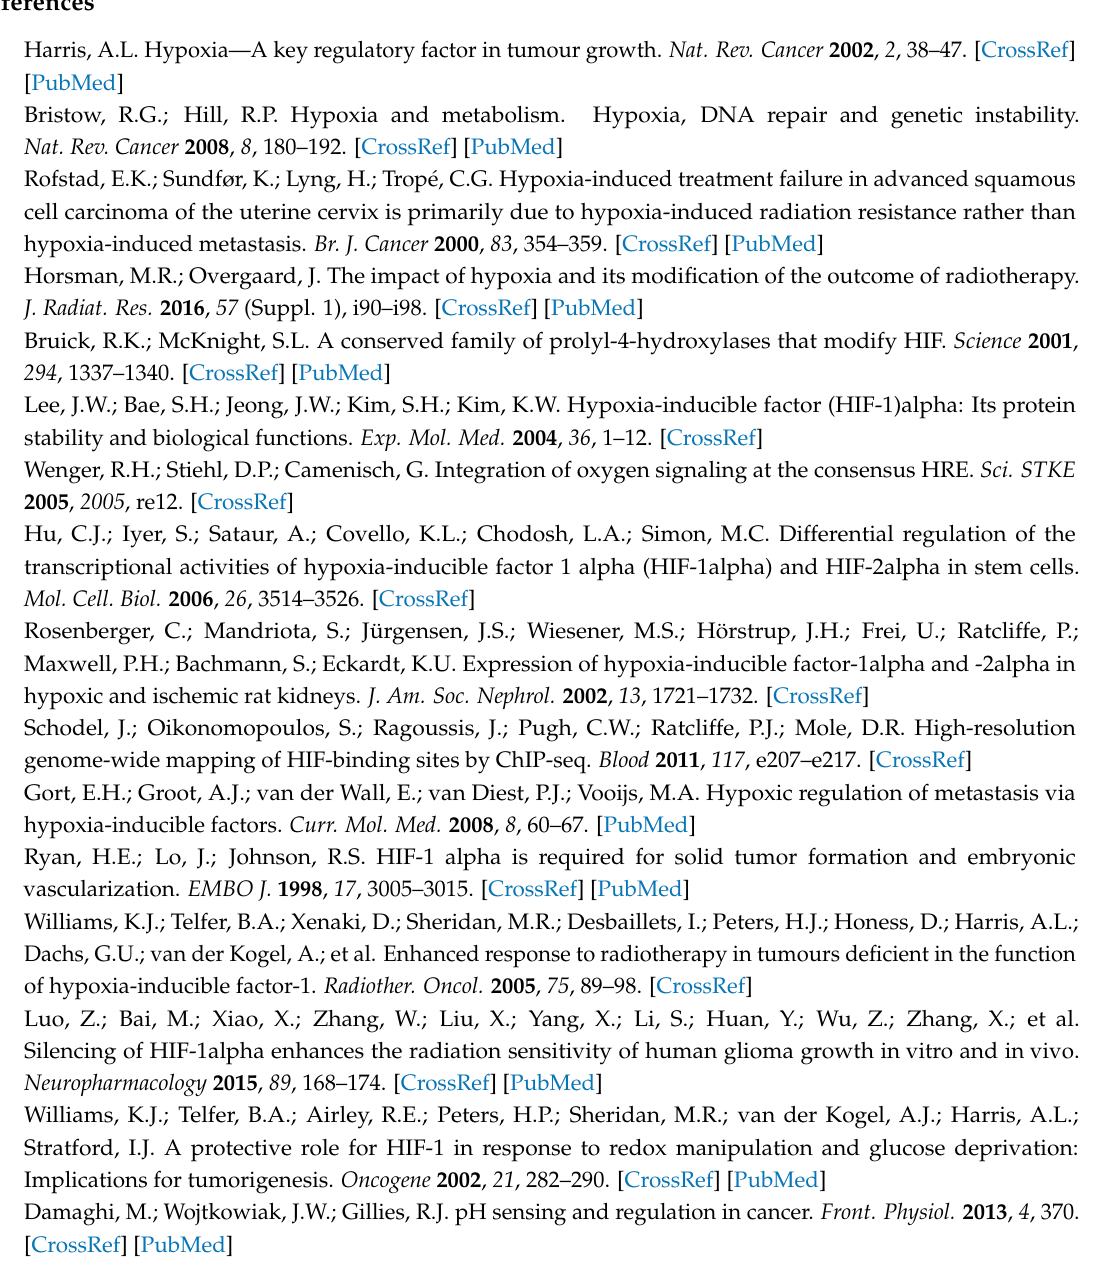
control. Figure S5: Western blot of pCHK2 expression in H1299 cells irradiated under normoxic (21%) and hypoxic (0.2%) conditions. Lamin A was used as loading control. Figure S6: Basal glycolytic function of H1299 cells under normoxia without (A) or with DFO (B) for 24 h was quantified by measuring extracellular acidification rate (ECAR). Basal respiration expressed as oxygen consumption rate (OCR) under normoxia without (C) or with DFO (D). Stacked plot of glycolysis and glycolytic reserve under normoxia without (E) or with DFO (F). Average ± SD of three independent biological repeats is shown. Asterisks indicate statistical significance (* p < 0.05; ** p <